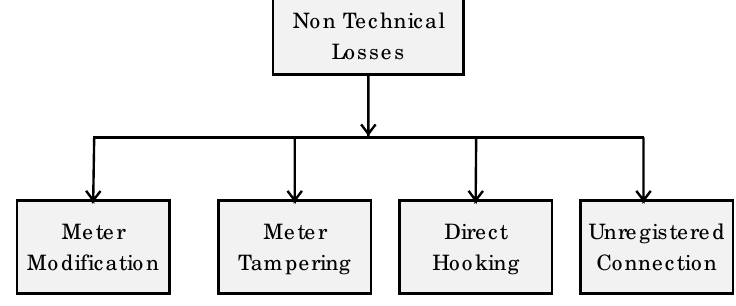
Figure 1. Types of non-technical loss